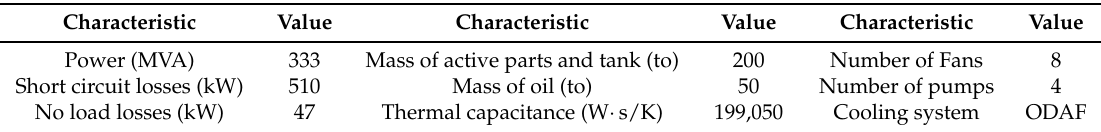
Table 3 . Characteristics of the transformer under study. ODAF: oil directed air forced.